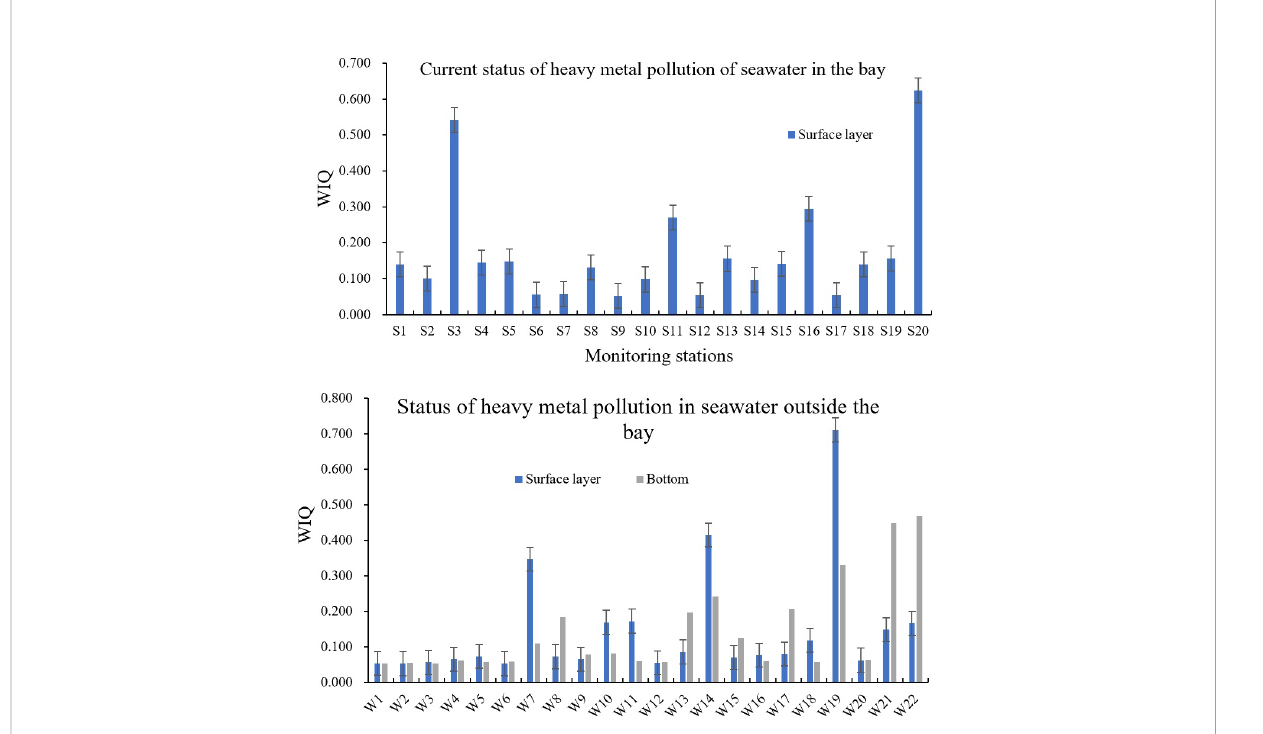
FIGURE 6 Distribution of TTHQ inside and outside Daya